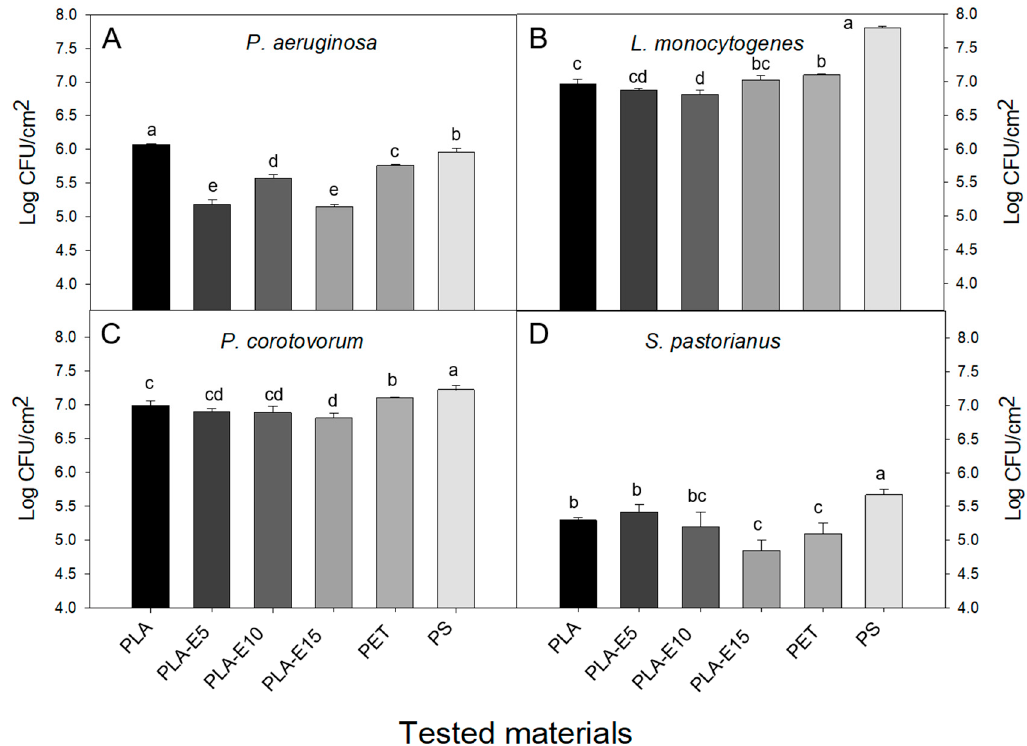
Figure 4. Adhesion of P. aeruginosa ( A ), L. monocytogenes ( B ), P. corotovorum ( C ) and S. pastorianus ( D ) microorganisms onto PLA, PLA-E films, polyethylene terephthalate (PET) and polystyrene (PS) samples. The bars indicate standard error ( n = 3). Different letters indicate significant differences between CFU counts according to the Duncan test ( p < 0.05).